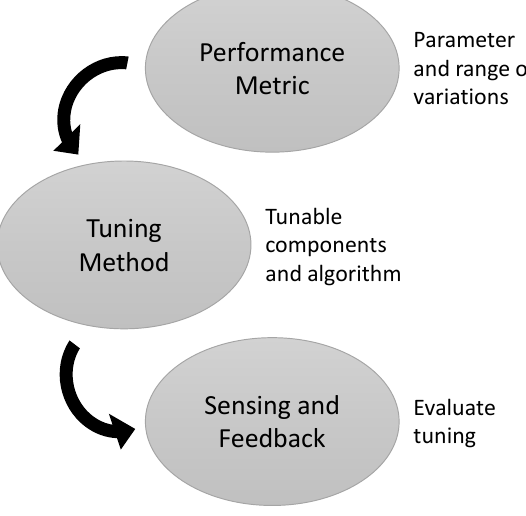
Figure 3. General process steps in designing an adaptive